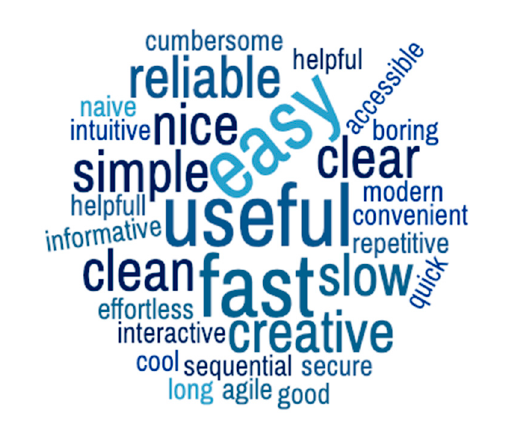
Figure 3. User characterization word cloud.